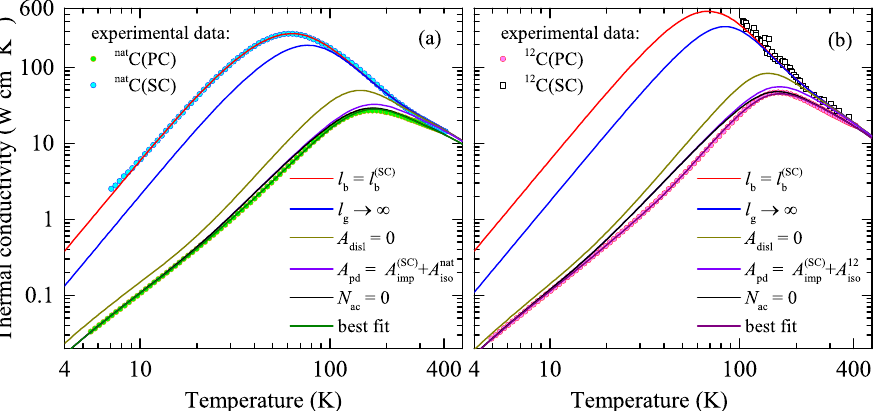
Figure 3. Thermal conductivity as a function of temperature for different sets of resistive phonon scattering processes: ( a ) Is for natural isotopic composition nat C and ( b ) is for an isotopically-enriched one 12 C. Symbols are experimental data: Circles are data for the polycrystalline nat C (green) and 12 C (pink) samples studied in this work; blue circles are data for pure single crystal [26]; open squares are data for single crystal 12 C(99.9%) of [4]. Solid lines are the results of our calculations.